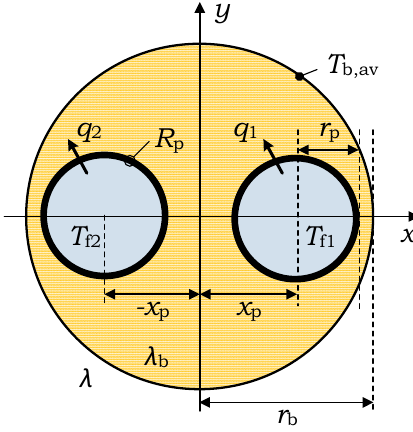
Figure 3. Two symmetrically placed pipes in a grouted borehole.